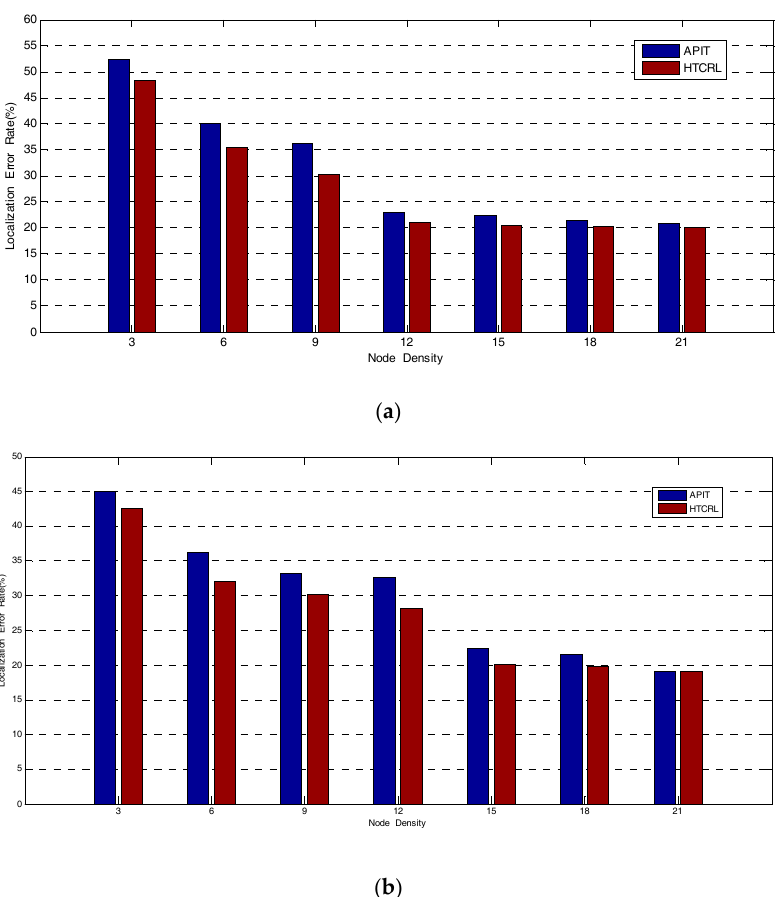
Figure 12. Localization Error Rate Varying Node Density. ( a ) ND = 3~21, AH = 18, ANR = 3, AP = 20%, R = 150 m Random, K = 0.0050; ( b ) ND = 3~21, AH = 18, ANR = 3, AP = 30%, R = 150 m Random, K = 0.0050.